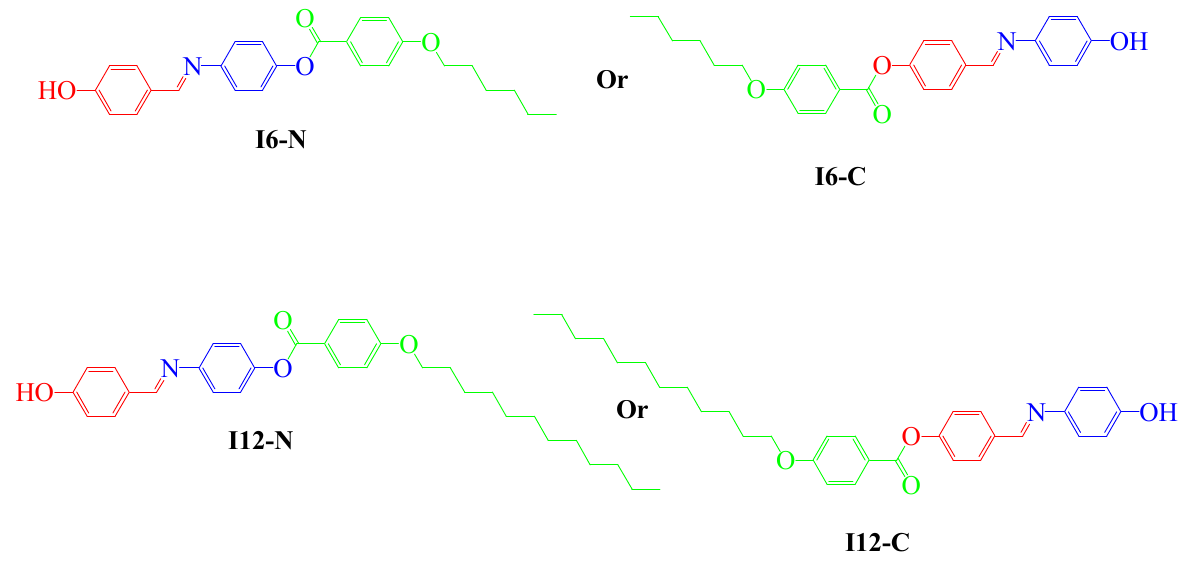
Figure 4. Configurationally isomers of two possible conformers of I 6 and I 12 derivatives as examples. Table 2. Relative energies for series I n and their isomers in kcal/mol. Isomer